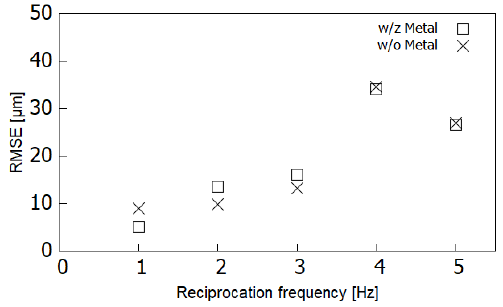
Figure 8. RMSEs of imaging sensor positioning with respect to the device reciprocation frequency for each condition with and without the metal placement close to the device.